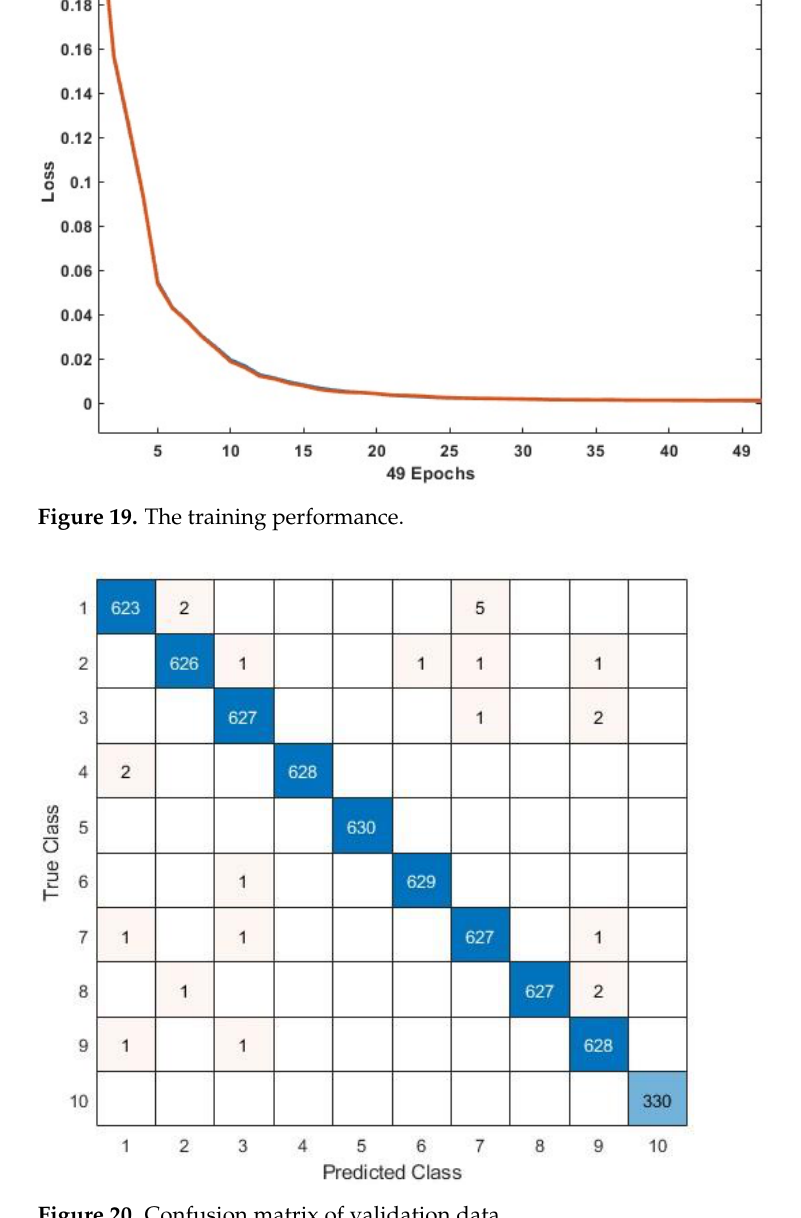
Figure 20. Confusion matrix of validation data.